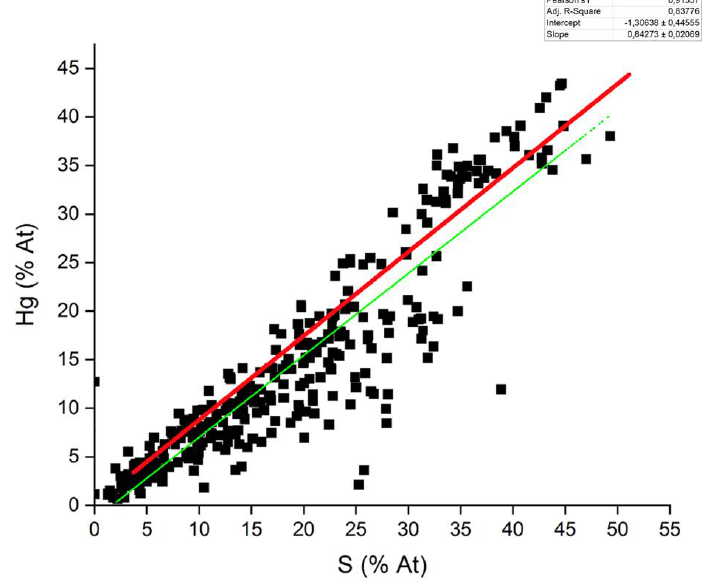
Figure 5. Atomic ratio (% At) between Hg and S in all the Hg particles found in both the sampling years in the Webb Hall . Green line and the coefficients refer to the regression analysis between the percentages of the two elements, while red line refer to the hypothetical 1:1 (atomic) ratio between these elements.